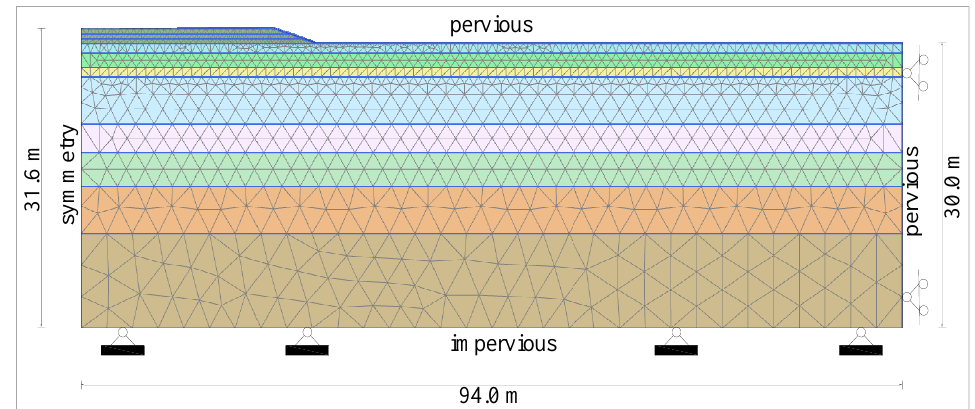
Figure 6. Mesh and boundary conditions — Embankment B.